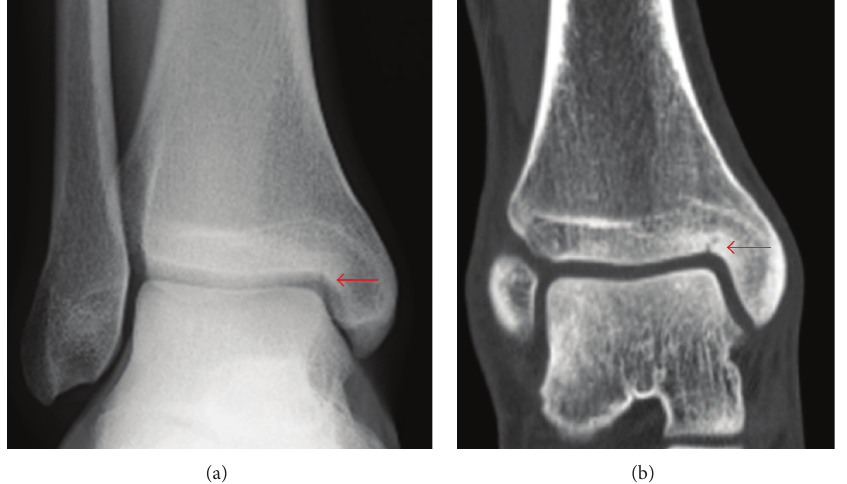
Figure 2: Anteroposterior radiograph (a) and coronal CT image (b) of the right ankle reveal a linear fracture line originating from superomedial corner of the ankle